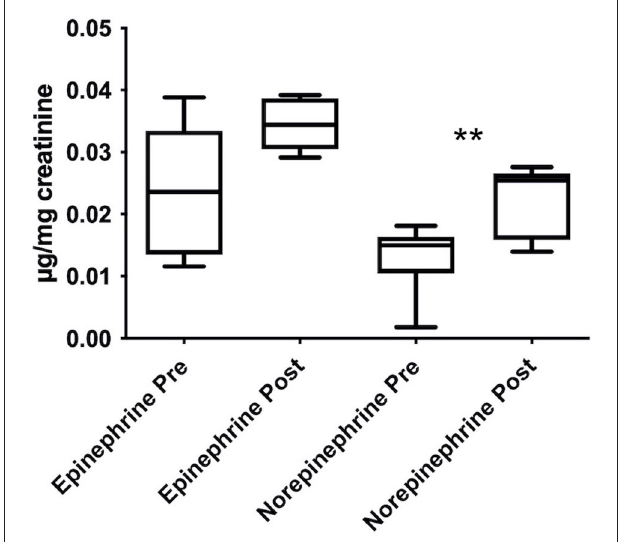
FIGURE 3 | Stimulating effects induced by HA trek on urinary norepinephrine and epinephrine levels, expressed as µ g/mg of creatinine and shown as boxplots. Urine samples were collected in Italians only. Data were analyzed through paired samples Student’s t -test; ** p <